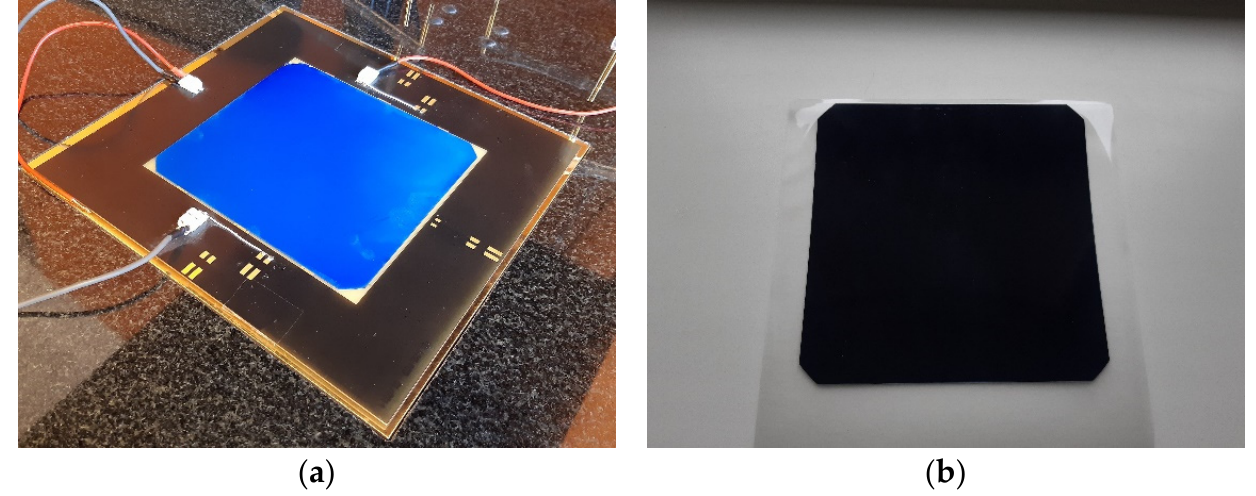
Figure 7. Solar cells samples: ( a ) Non-laminated solar cell in the test stand table; ( b ) Laminated solar cell coated with 100 µ m PVC film.